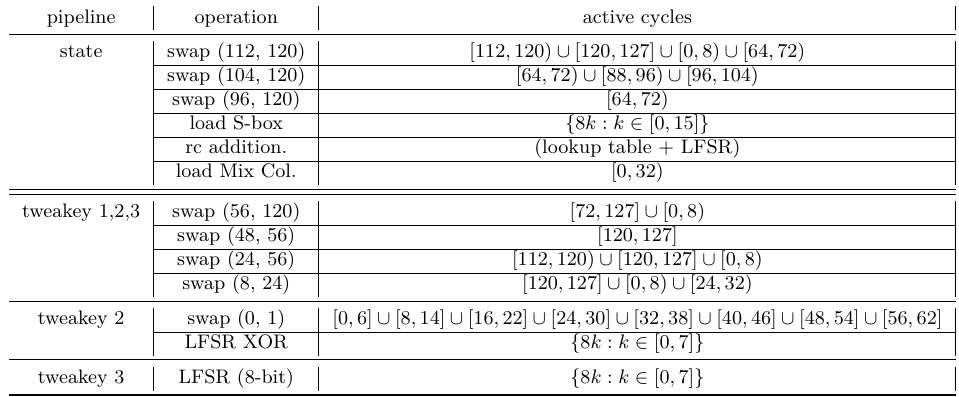
Table 7: The timetable of operations for bit-serial SKINNY-128-384 encryption circuit. pipeline